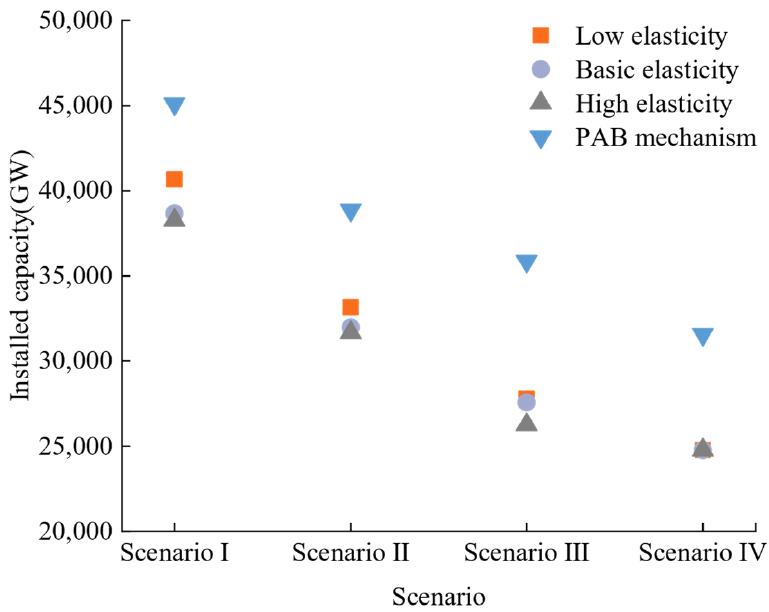
Figure 7. The market total installed capacity after planning under the PAB bidding mechanism and supply and demand adjustment mechanism.